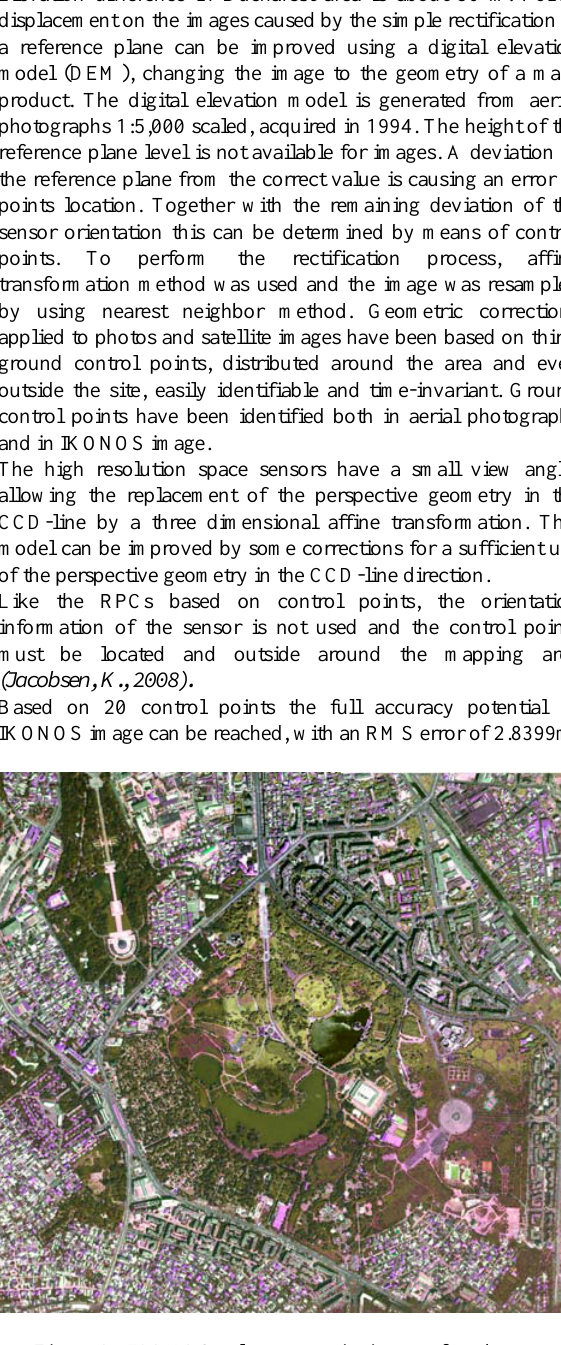
Figure 2. IKONOS color composite image of study area